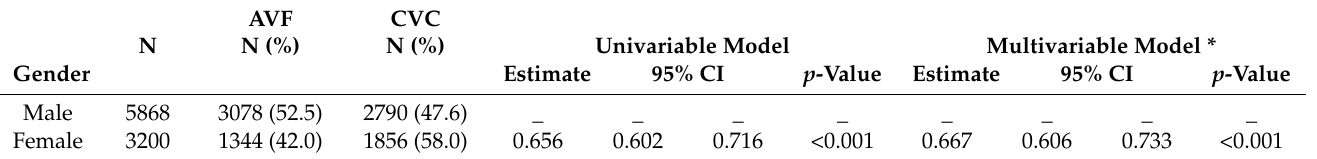
* Multivariable analysis adjusted for age class, BMI class, self-sufficient, cardiovascular risk factors, heart disease, peripheral vascular disease, chronic obstructive pulmonary disease, cancer, type of dialysis center and early referral to nephrologist. AVF, arteriovenous fistula; CVC, central venous catheter; CI, confidence interval.